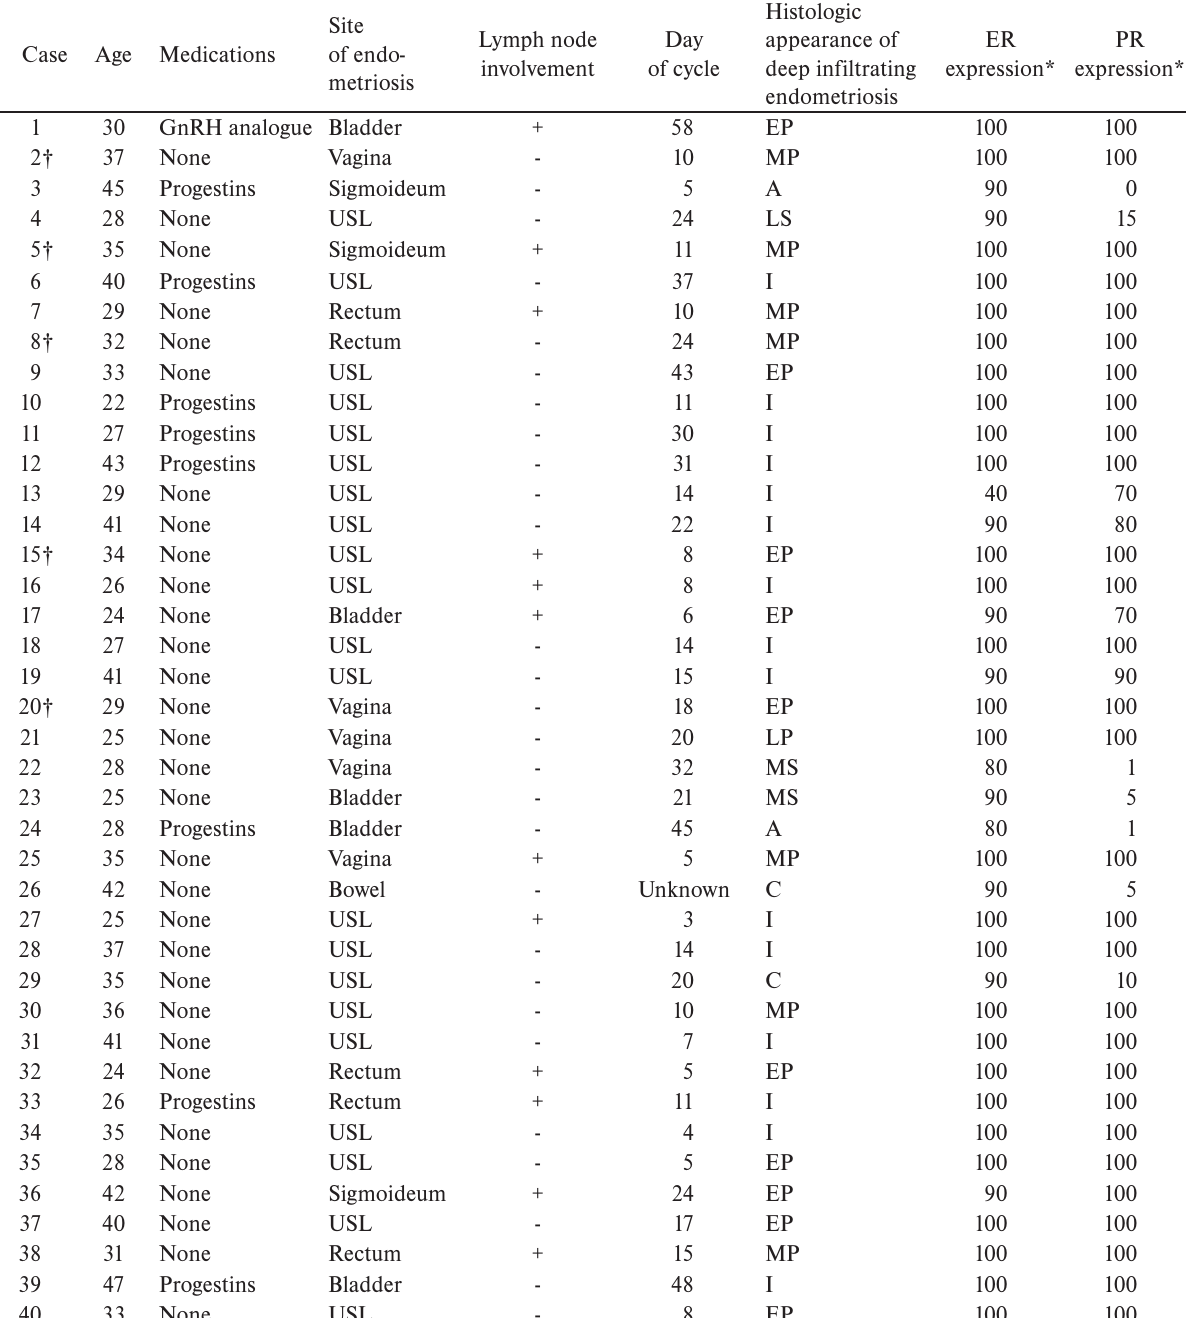
Table 1. Descriptive statistics of study population including pathologic features of deep infiltrating endometriosis and immuno- histochemical analysis of oestrogen and progesterone receptor expression in deep infiltrating endometriosis (group